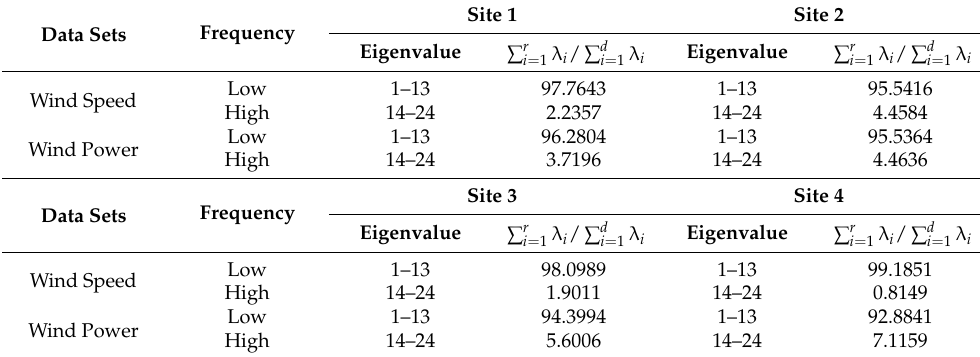
Table 3. Results for four sites after